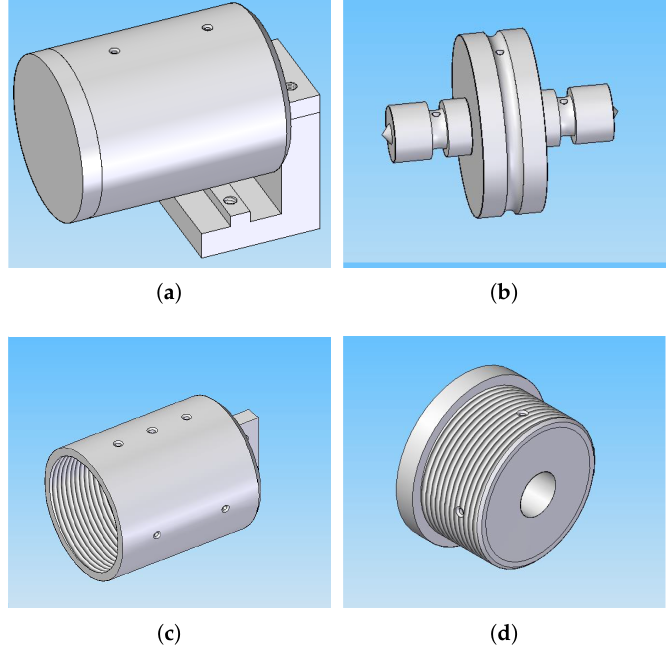
Figure 15. Gearbox 1:4 structure components. ( a ) Gear 1:4; ( b ) Gear unit pulleys; ( c ) Gear housing; ( d ) Gear